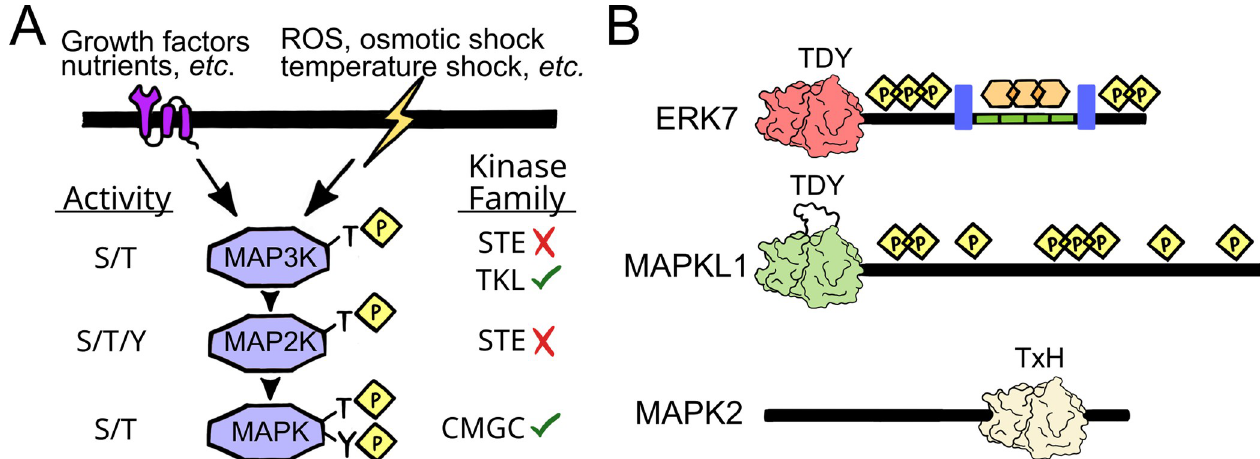
Fig 1. Overview of MAPK signaling. AU : AbbreviationlistshavebeencompiledforthoseusedinFigs 1 (cid:0) 4 : Pleaseverifythatallentriesarecorrect : (A) In a canonical MAPK signaling cascade, a signal results in activation of the upstream MAP3K (the “MAPK kinase kinase”), which phosphorylates and activates the MAP2K (the “MAPK kinase”), which in turn phosphorylates its target MAPK on both Thr and Tyr. Apicomplexan parasites lack the STE kinase family, to which all MAP2Ks belong. They therefore encode no MAP2Ks or MAP3Ks. (B) Domain architecture of the apicomplexan MAPKs (not to scale). ERK7 and MAPKL1 both have long CTEs that are predicted to be intrinsically disordered by IUPRED [75]. The ERK7 CTE contains sequence repeats (green; Sarcocystidae only). In Toxoplasma , both phosphorylation (yellow diamonds) and fucosylation (orange hexagons) sites have been identified. The Plasmodium ERK7 CTE also has one or more predicted nuclear localization signals (purple rectangles), though no post-translational modifications of the CTE have been identified as of yet. The Toxoplasma MAPKL1 CTE is also phosphorylated. Many MAPKL1 family members have an extended activation loop that reaches a maximum of approximately 100 residues in Sarcocystidae. Most MAPK2 proteins have a disordered N-terminal extension. The activation motifs for each of the apicomplexan MAPK subfamilies are indicated above the kinase domain. CTE, C-terminal extension; MAPK, mitogen-activated protein kinase.